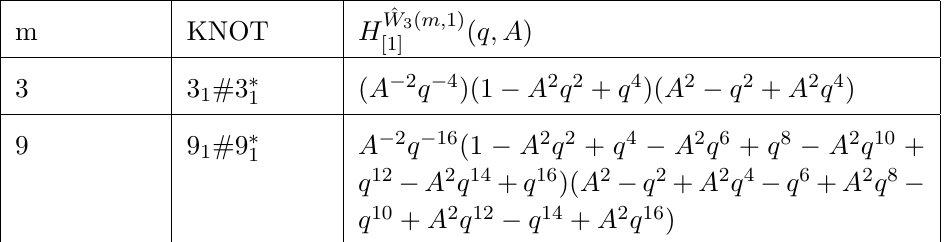
Table 3 . HOMFLY-PT for ˆ W 3 ( m, 1) = T